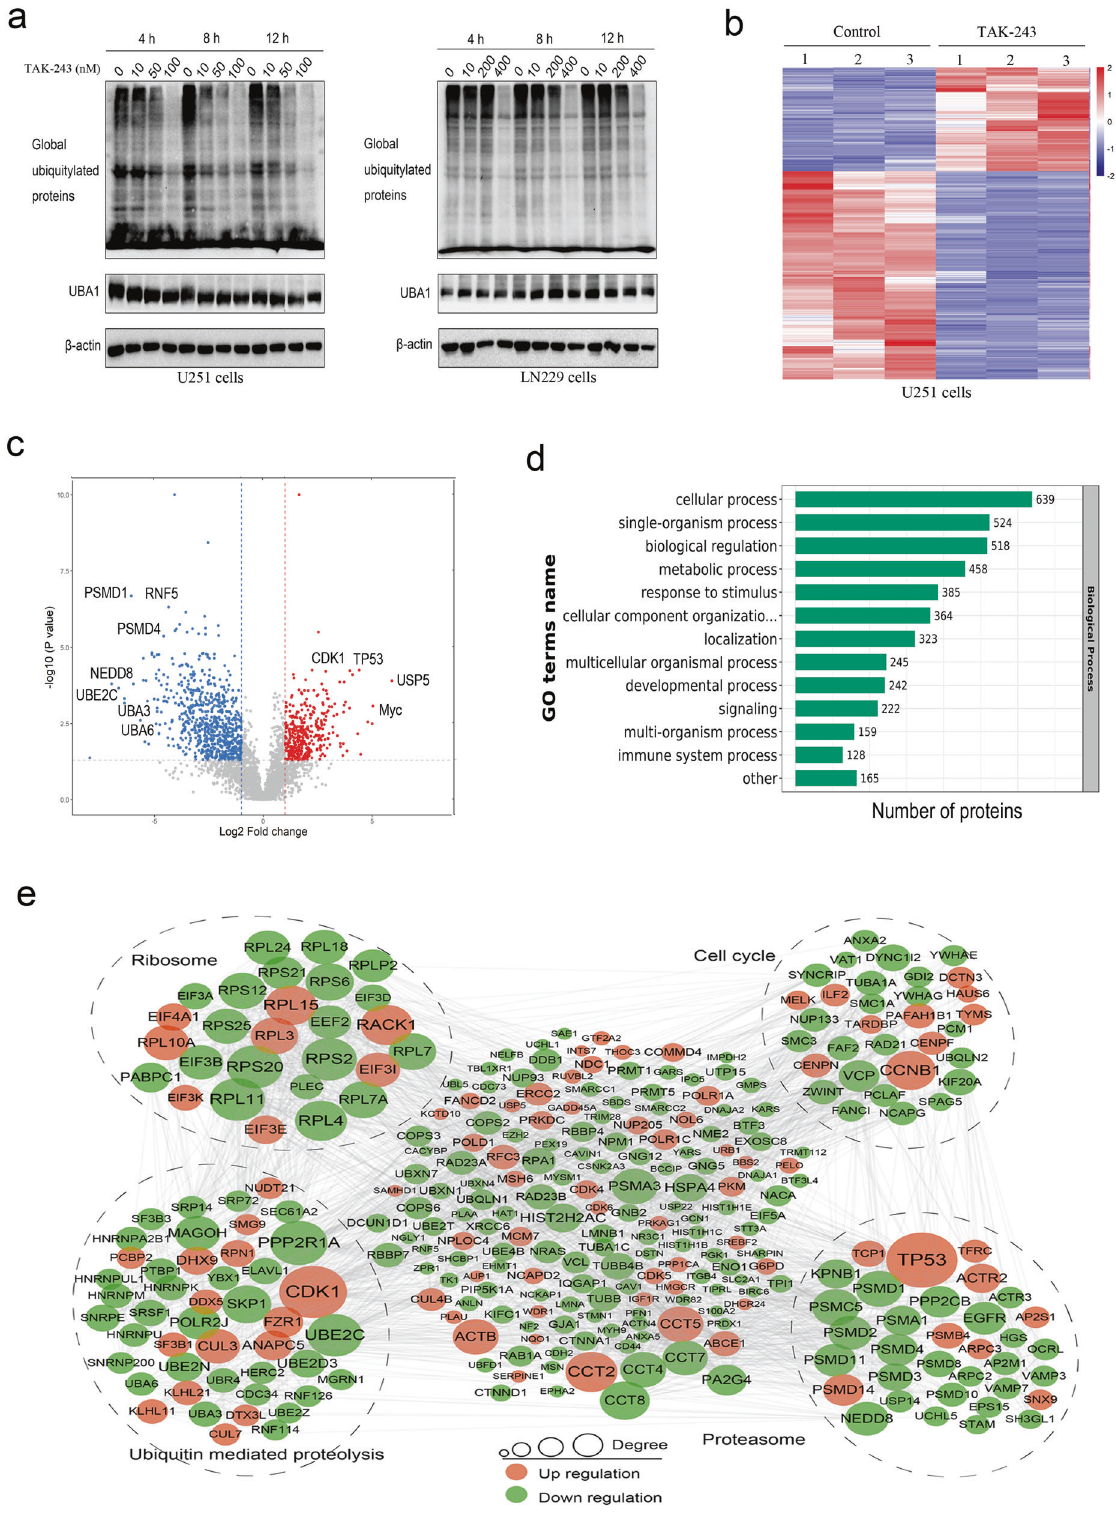
Fig. 3 Quantitative proteomics reveals the changes in global protein ubiquitylation during TAK-243 treatment. a GBM cells were treated with increasing concentrations of TAK-243 for indicated times. Then, the whole-cell lysates were prepared and levels of global ubiquitylated proteins, UBA1 and β -actin were measured by immunoblotting. b Heatmap of the differentially ubiquitylated proteins between control and TAK-243 treatment groups. c Volcano plot showing the quantitative levels of ubiquitylated proteins between control and TAK-243 treatment groups. d Gene Ontology (GO) enrichment analysis of the differentially ubiquitylated proteins between control and TAK-243 treatment groups. e Protein − Protein interaction networks functional enrichment analysis of the differentially ubiquitylated proteins using STRING